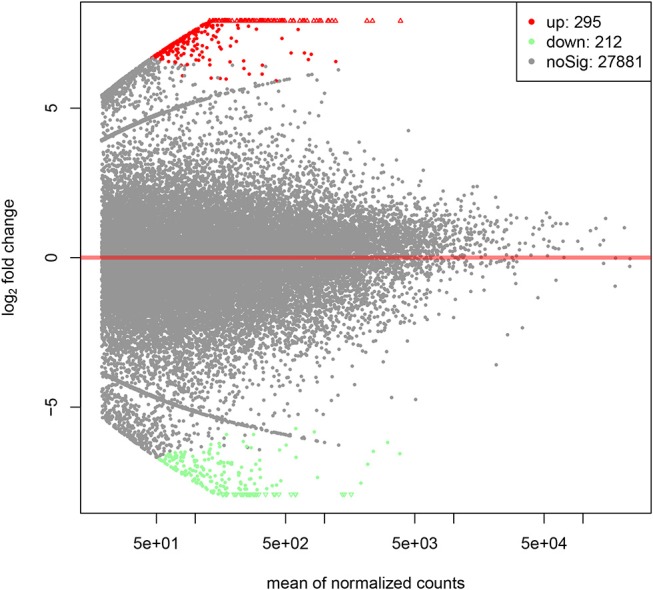
The MA plot of distinct gene expression profiles in GH cultured oocytes compared to the control group according to adjusted P-value < 0.05. X-axis represents the mean of normalized counts between the two groups; Y-axis represents the logarithm of fold change. From left to right in the X-axis, the expression level of the genes is from low to high. In the Y-axis, the more deviation it is from Y = 0, the larger the fold change is.